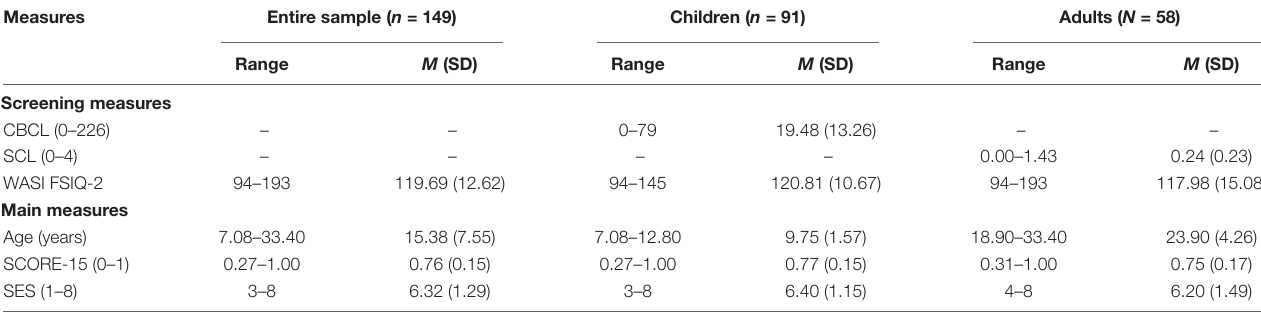
TABLE 1 | Sample descriptives.